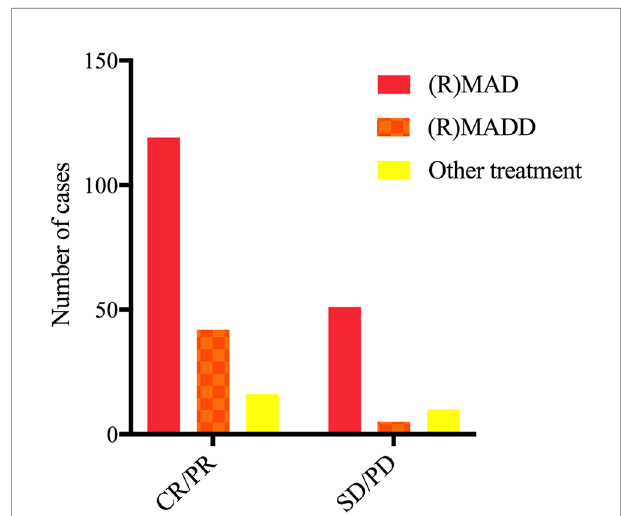
FIGURE 1 | Response to fi rst-line treatment.